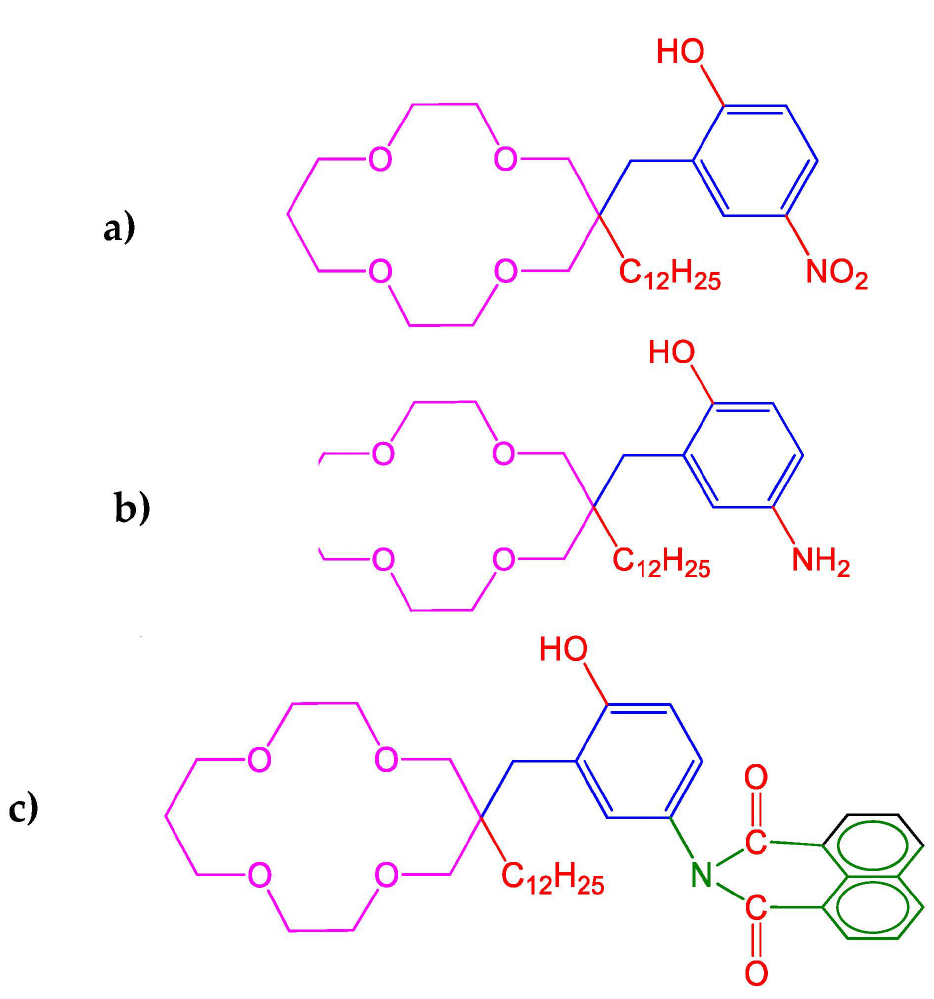
Figure 13. Structures of 14-crown-4 derivatives 17 ( a – c